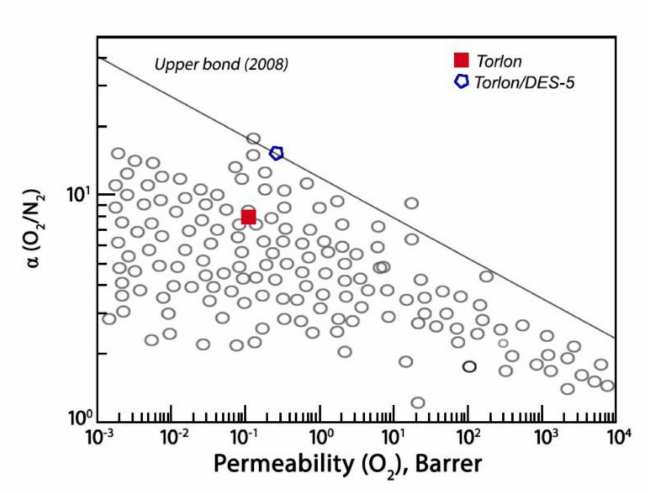
Figure 11. Oxygen/nitrogen selectivity as a function of oxygen permeability. The upper bound line was taken from Robeson’s diagrams